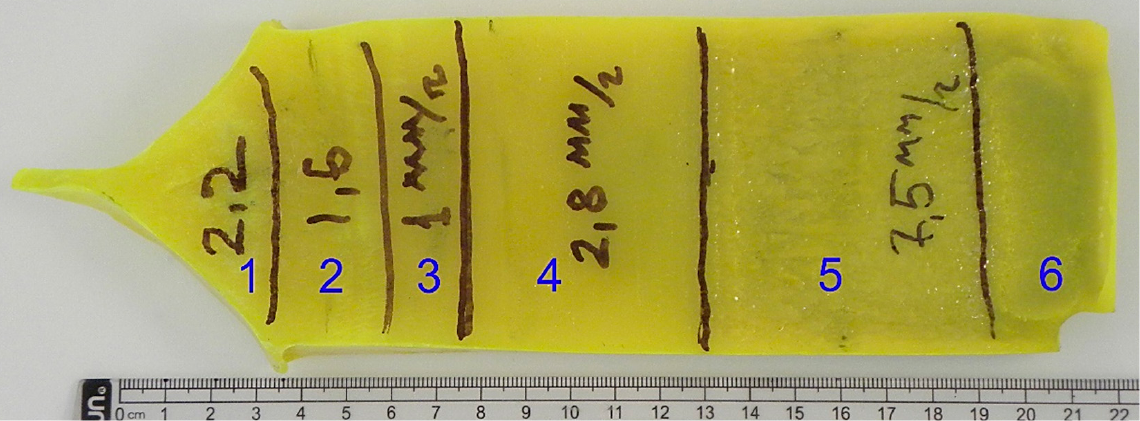
Figure 1. The (Al 2 O 3 -YAG):Ce eutectic ingot, different parts of the ingot grown at different crystallization rates (Table 1). Table 1. Modes of crystallization of eutectic samples.